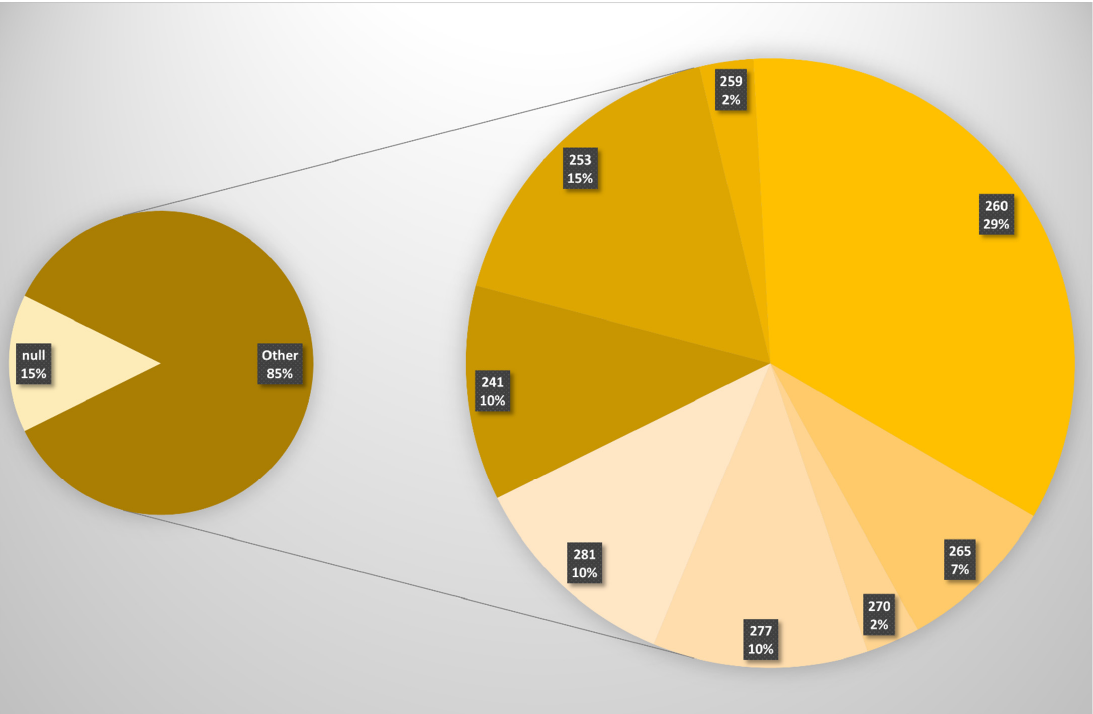
Figure 2. Ratio of alleles in VVMD32 SSR locus with probably null alleles. Data from the study of Martinez et al. [53]; cultivars with triple alleles were ignored, and allele frequencies were calculated by MolMarker [16].